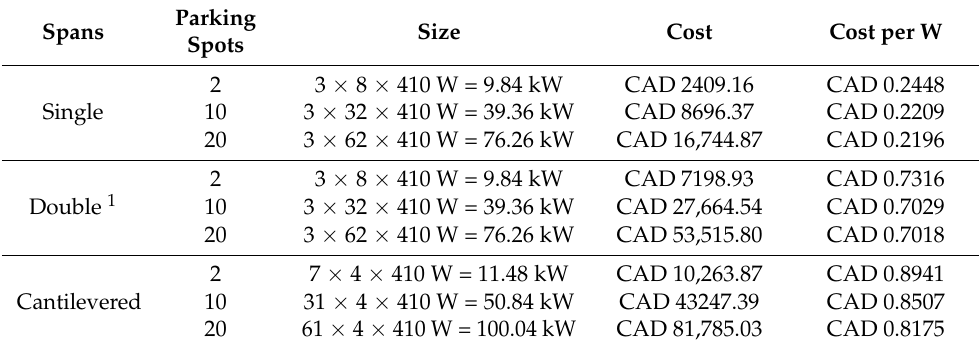
Table 8. Cost per W for each system in